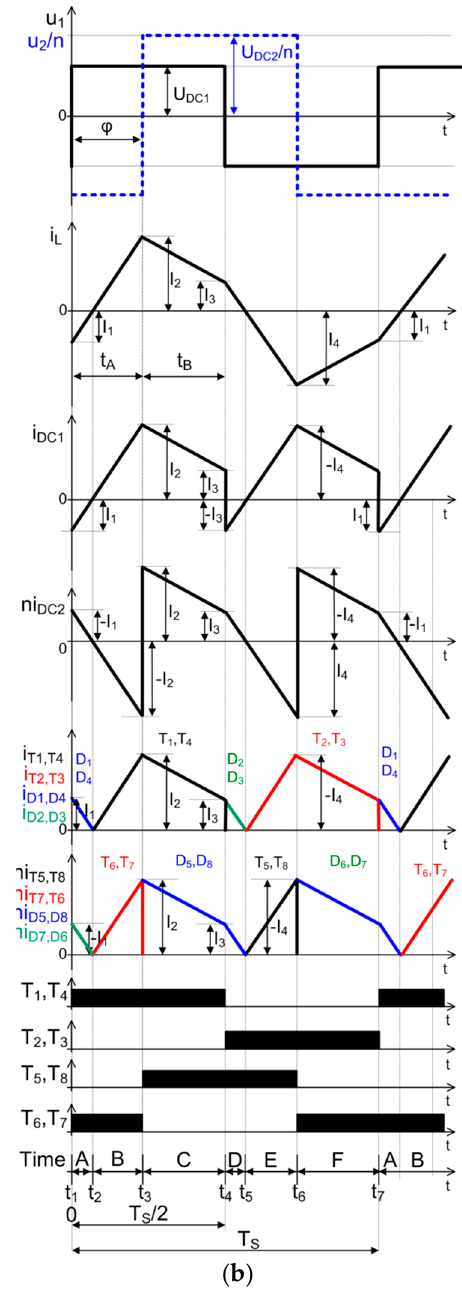
Figure 4. Simplified voltage and current waveforms of the DAB converter for U DC 1 < U DC 2 / n : ( a ) with I 1 > 0; ( b ) with I 1 < 0.